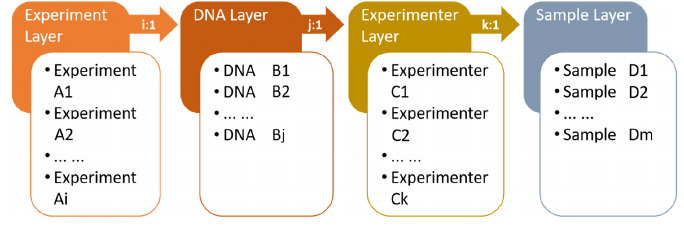
Figure 1. Schematic representation of the Fingerprint Merging Algorithm.